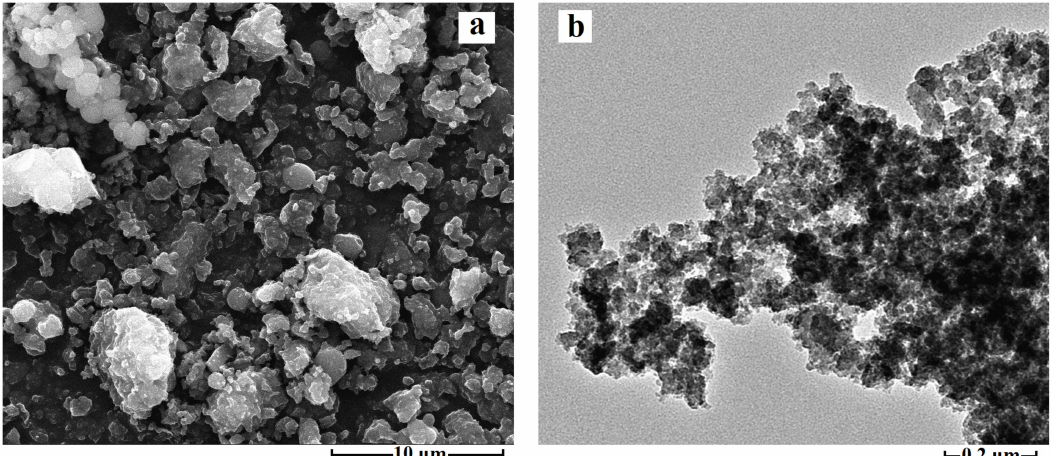
Figure 6. FE-SEM ( a ) and TEM ( b ) images of [C 3 mim] + Cl − @SiO 2